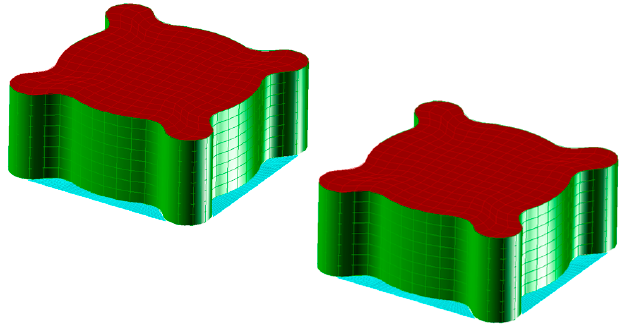
Figure 4. Patches for the numerical models of floating tanks. Note the light blue patches are the damping plates to model bottom